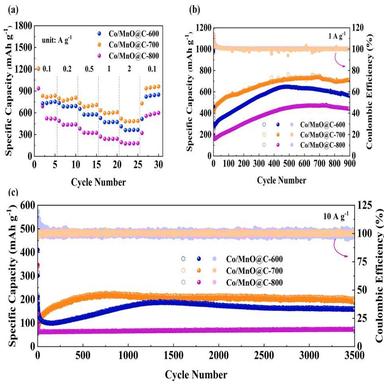
(a) Rate performance for Co/MnO-LC@C composites at 0.1–2 A g− 1 . Cycling performances for Co/MnO-LC@C composites at the current rates of (b) 1 A g− 1 , (c)10 A g− 1 .